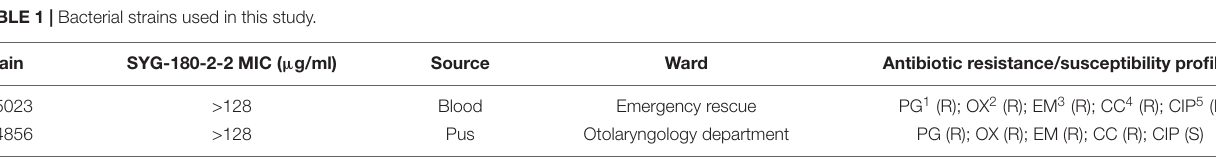
FIGURE 1 | Synthetic process of SYG-180-2-2. 1: N -pivaloyl indoles. 2: N -(1-pivaloyl-1 H -indol-7-yl) benzamide. SYG-180-2-2: desired product. TABLE 1 | Bacterial strains used in this